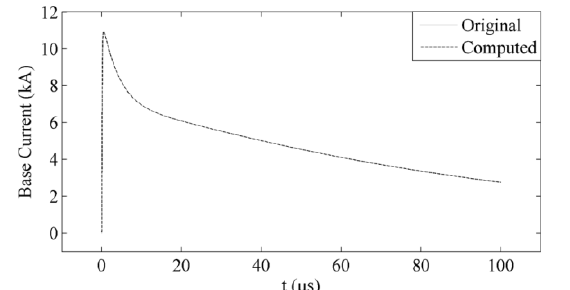
Figure 4. Comparison of a computed lightning channel base current with the assumed current model. Notice that for all distances from the lightning channel, the estimated current overlapped with the assumed model depicted as “Original” in the figure panel.